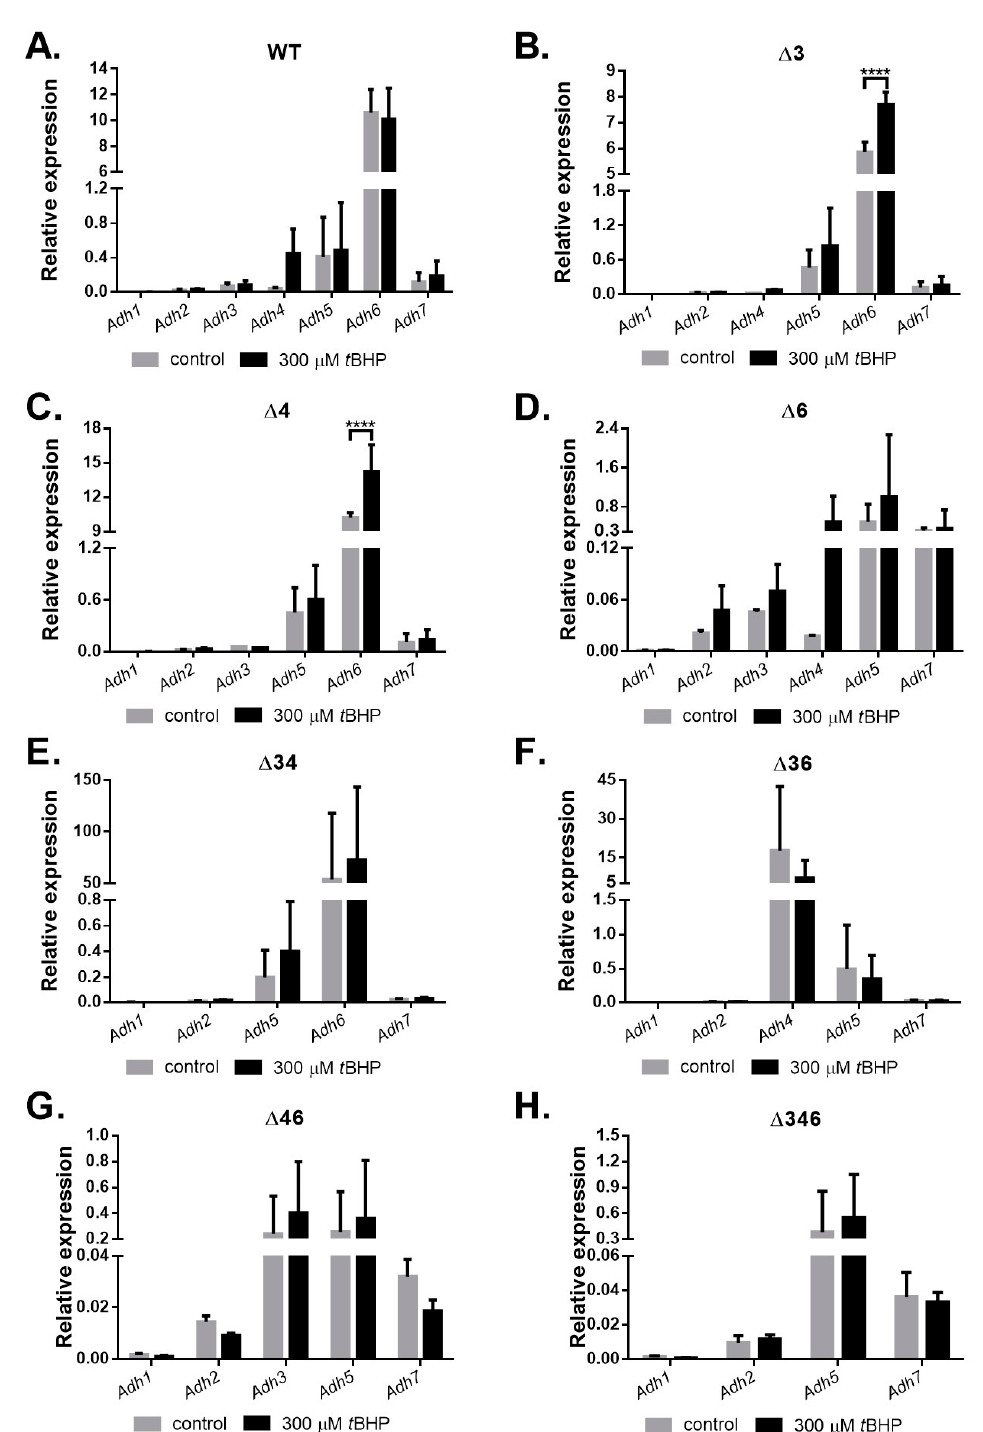
Figure 7. Relative gene expression of Adh genes in wild-type and mutant strains after treatment with tert -BHP for 20 min. Comparison of relative gene expression for A. baumannii ATCC 19606 ( A ) wild-type; ( B ) ∆ 3 single mutant; ( C ) ∆ 4 single mutant; ( D ) ∆ 6 single mutant; ( E ) ∆ 34 double mutant; ( F ) ∆ 36 double mutant; ( G ) ∆ 46 double mutant; and ( H ) ∆ 346 triple mutant strains cultured in M9 medium before (gray bar) and after 300 mM tert -BHP treatment for 20 min (black bar). Two-way ANOVA tests were conducted to assess statistical significance. **** p < 0.0001.